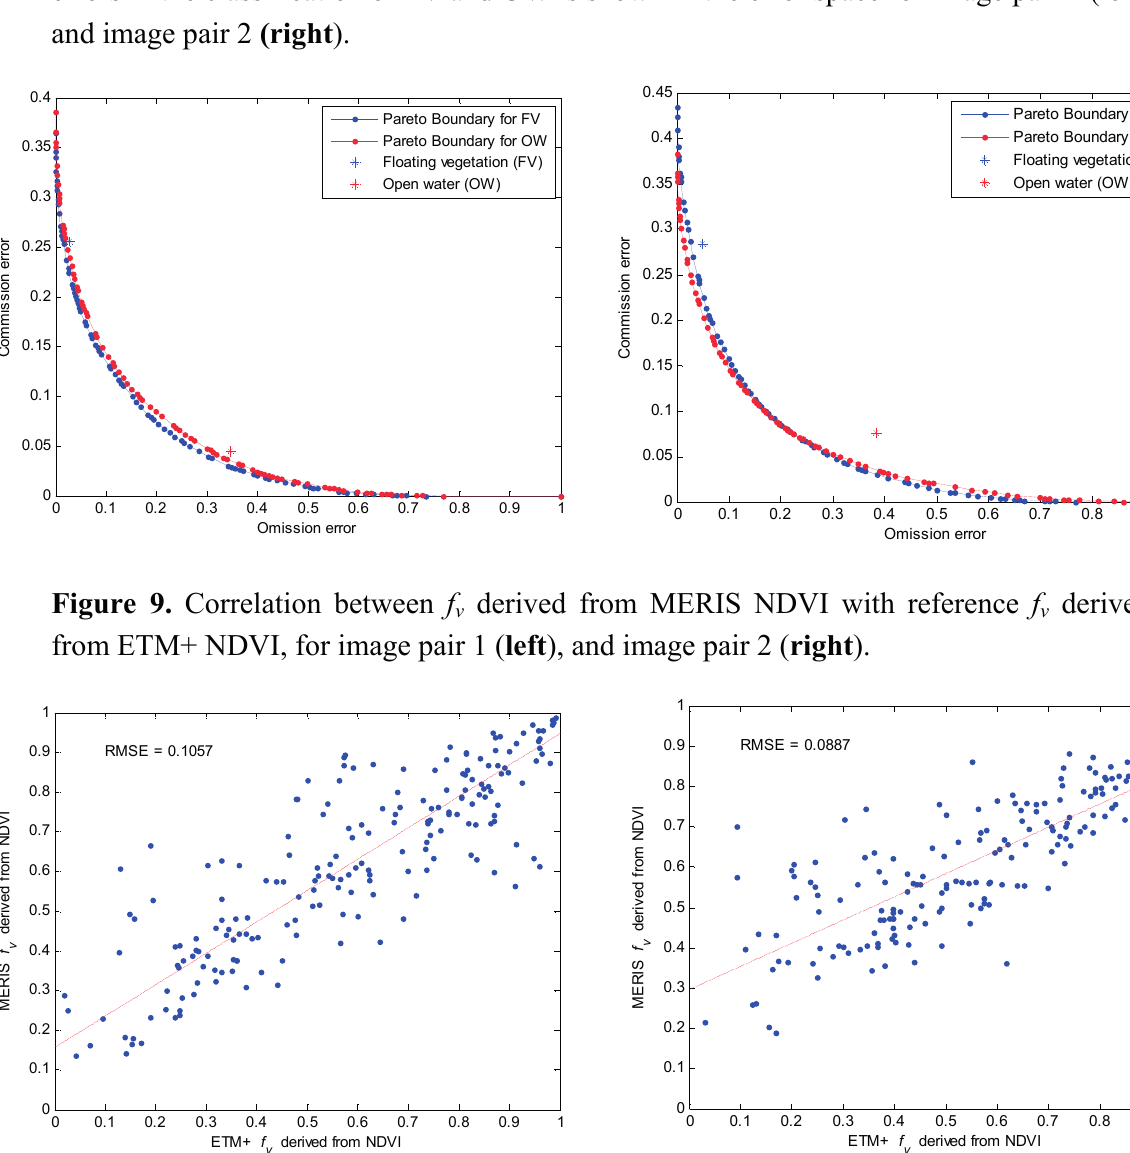
Figure 8. An analysis of the trade-off between commission and omission errors in the classification of floating vegetation (FV) and water (OW) by maximum likelihood. Pareto Boundary shows the optimal classification that can be achieved with coarse resolution MERIS data with reference obtained from ETM+. Positions of the omission and commission errors in the classification of FV and OW is shown in the error space for image pair 1 ( left ) and image pair 2 (right ).